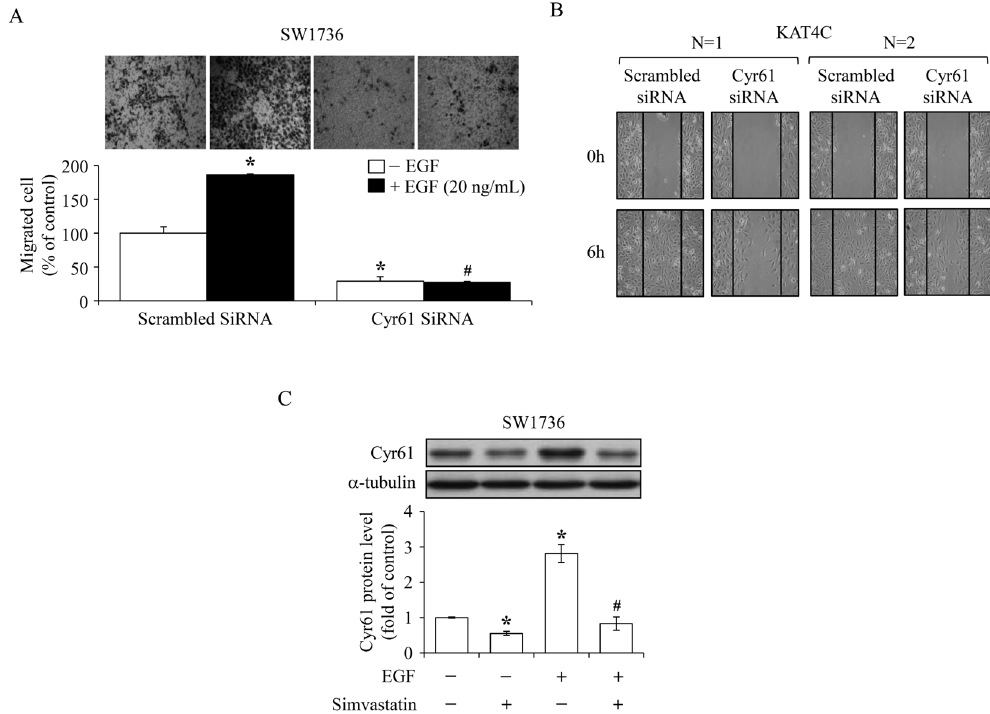
Figure 7. Role of Cyr61 in ATC cell migration. Introduction of Cyr61 siRNA remarkably reduced the migrated cell number of SW1736 ( A ) and KAT4C ( B ) cells. In ( A ), after introduction of Cyr61 siRNA (30 pmole) into SW1736 cells for 48 h, cells were seeded into upper chamber of Transwell containing 0% FBS. The medium in the bottom chamber contained 5% FBS. Cells were incubated in the Transwell for additional 24 h, and then the migrated cells attracted by the culture medium containing 5% FBS with or without EGF on the side of lower chamber of Transwell were counted. Values represent the means ± SEM ( n = 3). * p < 0.05 and # p < 0.05, different from corresponding control. In ( B ), Cyr61 siRNA (20 pmole) was introduced into KAT4C cells for 48 h followed by a creation of migration gap. Cells were incubated for additional 6 h, and then the cells in the migration gap were counted. Similar results were shown in two independent experiments. ( C ) Simvastatin (10 µ M) prohibited the EGF-increased expression level of Cyr61 protein in SW1736 cells. Cells were pre-incubated with simvastatin for 4 h followed by EGF treatment for additional 1 h. The Cyr61 protein level was then analyzed. α -Tubulin served as control for equivalent loading. Values represent the means ± SEM ( n = 3). * p < 0.05, different from corresponding control. # p < 0.05, different from EGF-incubated only group.